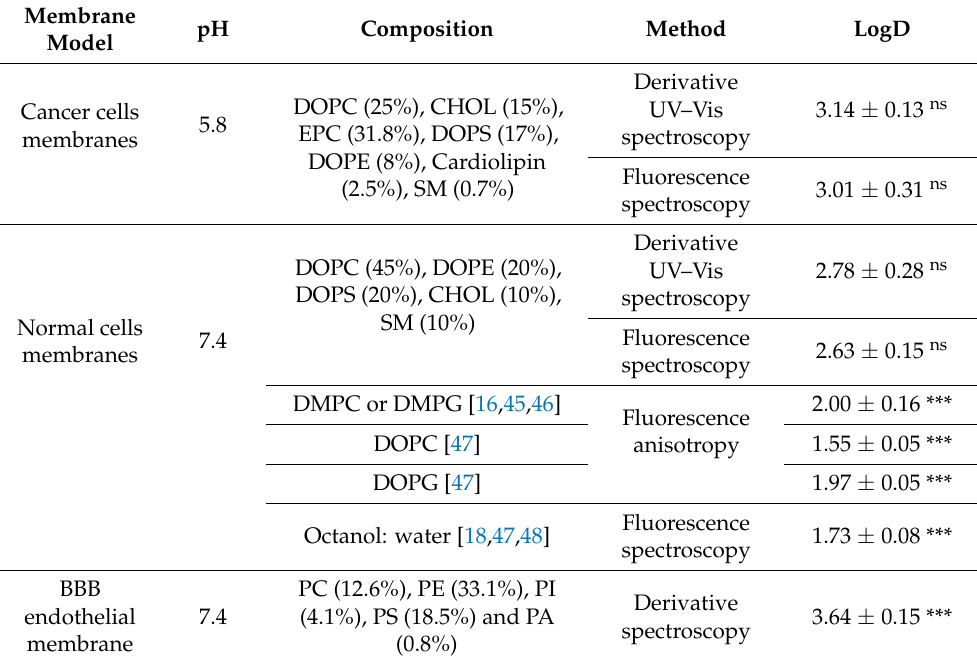
Table 2. Distribution coefficients of CPT obtained in a biphasic membrane/aqueous system. Membrane Model